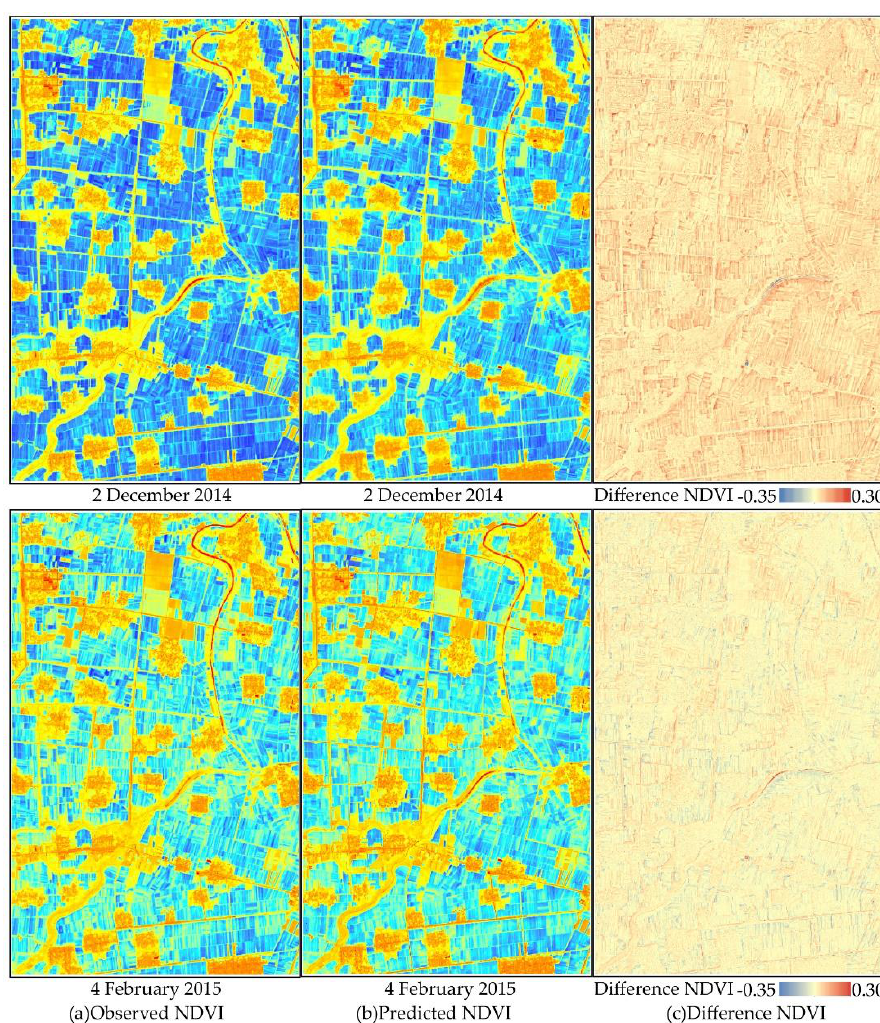
Figure 4. Comparison of observed ( a ) and predicted NDVIs ( b ), and the distribution of difference NDVI ( c ).